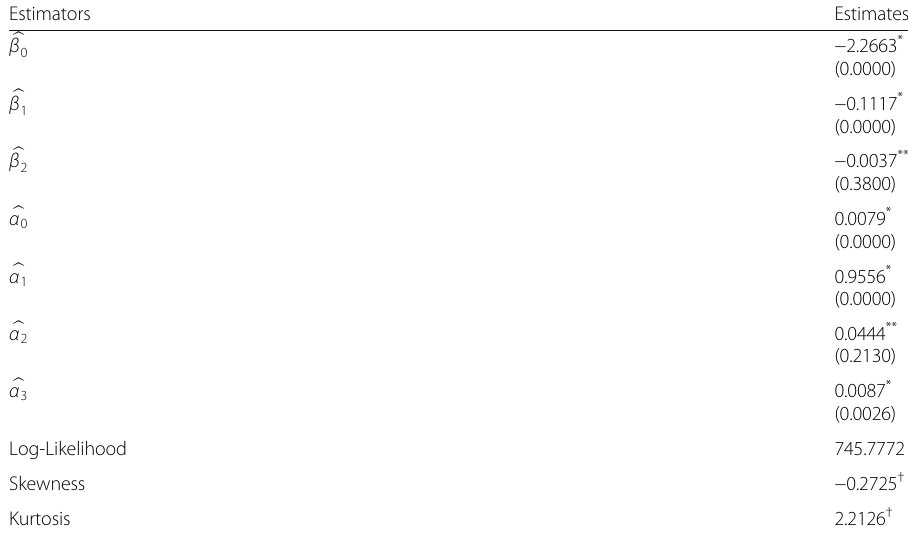
Table 3 First stage V-IGARCH(1,1) regression model (Equation 2) Estimators